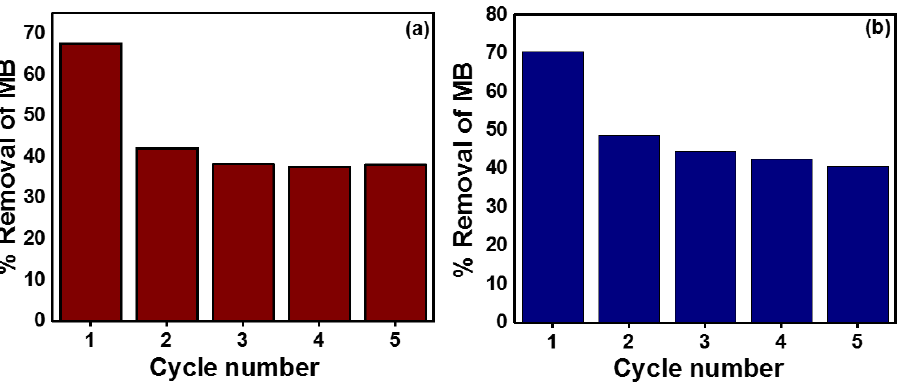
Figure 15. Removal of MB in five consecutive cycles ( a ) with washing and ( b ) without washing the catalyst.